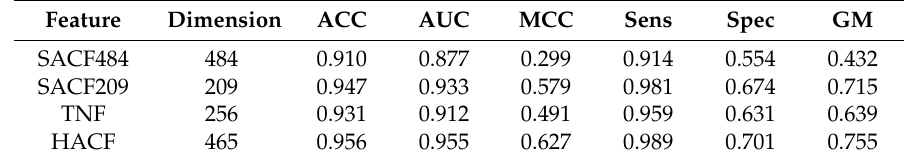
Table 1. Prediction results of four inputs on dataset Enhancer4589 using a five-fold cross-validation test.